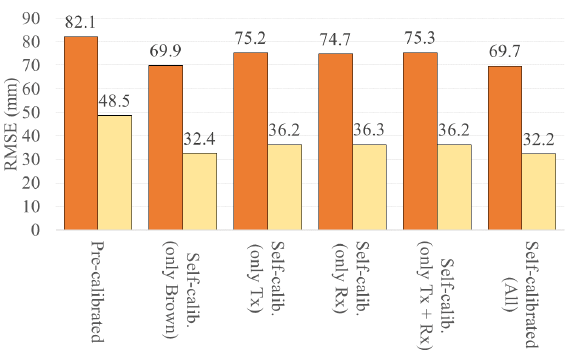
Figure 5 . DSM comparison results (orange bars) and RMSE of Check Points (yellow bars) obtained with the different calibration strategies in Block 4.